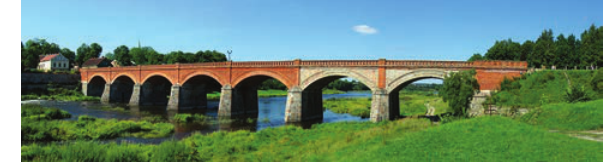
Fig. 1. Side view of the bridge before reconstruction